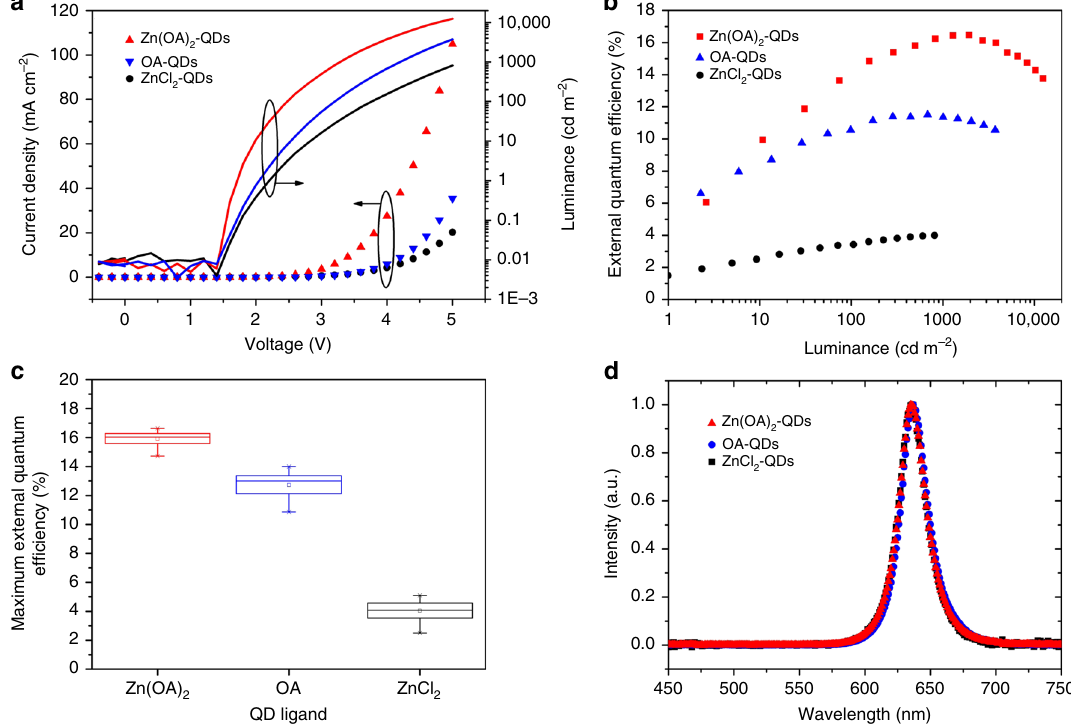
Fig. 5 IJP QLED characterizations. a Current – voltage – luminance characterization of Zn(OA) 2 -QDs vs. OA-QDs vs. ZnCl 2 -QDs devices; b external quantum ef fi ciency of Zn(OA) 2 -QDs vs. OA-QDs vs. ZnCl 2 -QDs devices; c statistic chart of maximum external quantum ef fi ciency of devices; d electroluminescent spectra of Zn(OA) 2 -QDs vs. OA-QDs vs. ZnCl 2 -QDs the energy level of CQDs, thus electroluminescent spectra are the same of all types of ligands (Fig. 5d). insigni fi cant hole current improvement was observed in ZnCl 2 - QDs hole only device. In case of Zn(OA) 2 -QDs, through our dual ion passivation, anion traps are effectively passivated, resulting a signi fi cant improvement of hole current. As the results, we have better balanced currents in Zn(OA) 2 -QDs devices. With higher PLQY and better charge balance, QLED with Zn(OA) 2 -QDs achieved the highest EQE of 16.6% (Fig. 5b). As far as we know, this is the fi rst time that reported an IJP QLED device with EQE over 15%. The average maximum EQE of each QD device is shown in Fig. 5c. The ligands we chose here have weak effect on